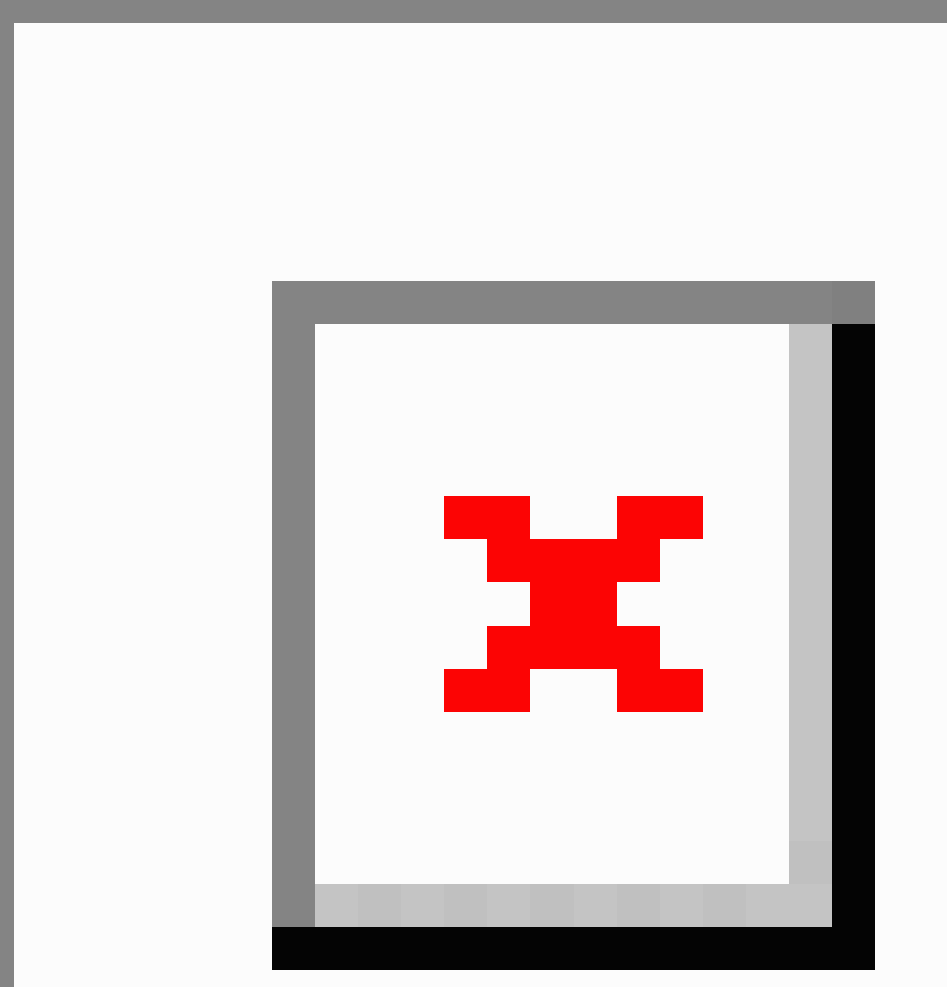
Figure 3. Assessment and management pathway for patients screened by the ASHA